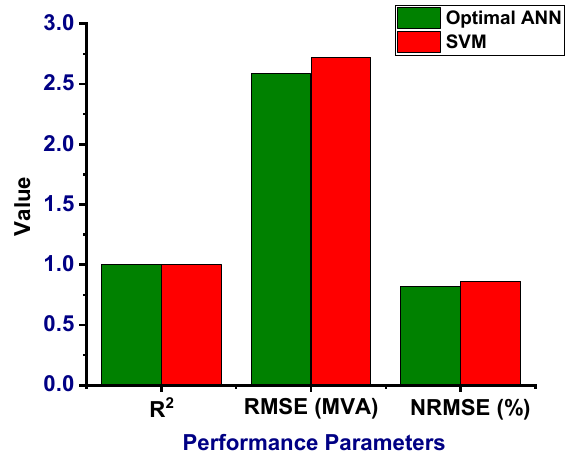
Figure 7. Performance comparison of optimal ANN and SVM in external validation